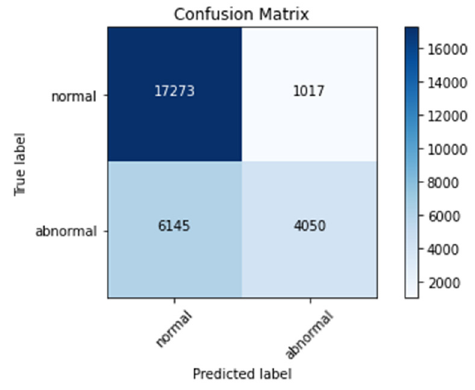
Figure 18. Confusion matrix for Model-3.